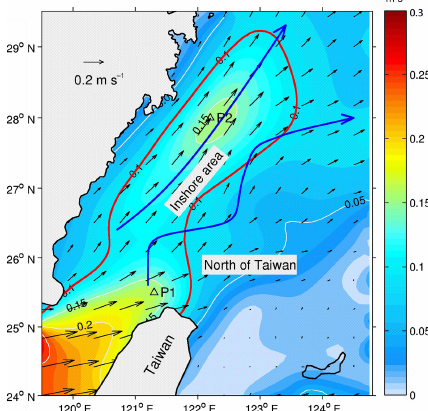
Figure 7. Current standard deviation in the layer of the VMV. The black arrows indicate the major axis of the ellipse, which represent the standard deviation of the current. The color shading shows the respective magnitude. The two blue arrows indicate the two TWC branches. The red curve indicates the area where the current stan- dard deviation is larger than 0.1ms − 1 and the branches’ represen- tative points (P1 and P2) are selected for later